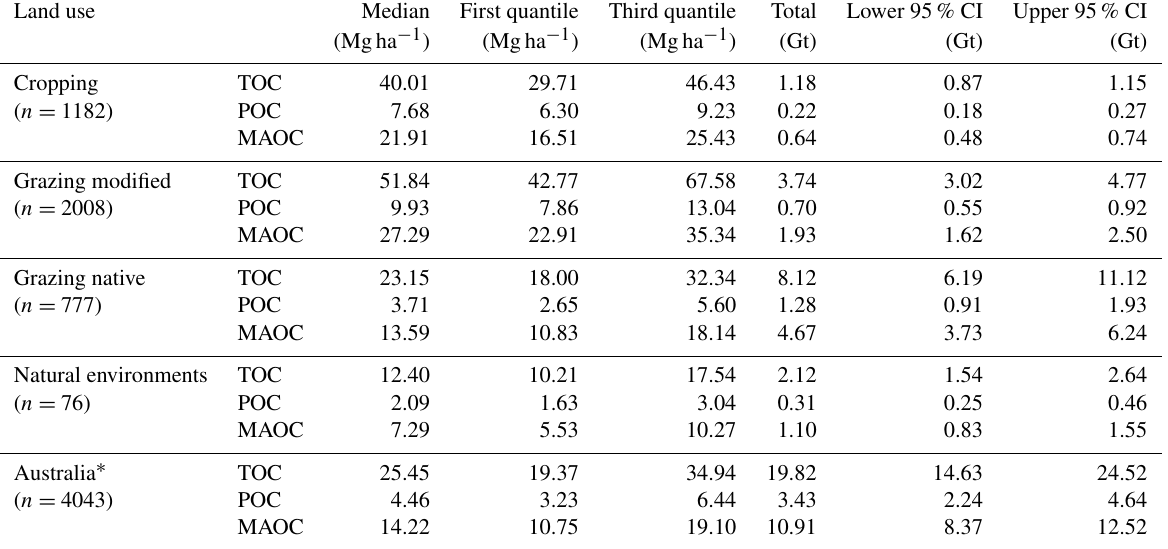
Table 1. The simulated stocks of total, particulate and mineral-associated organic C (TOC, POC and MAOC) under different land uses and in Australia. The total stocks of soil organic C were calculated from the median with the uncertainties expressed as an approximate 95% confidence interval